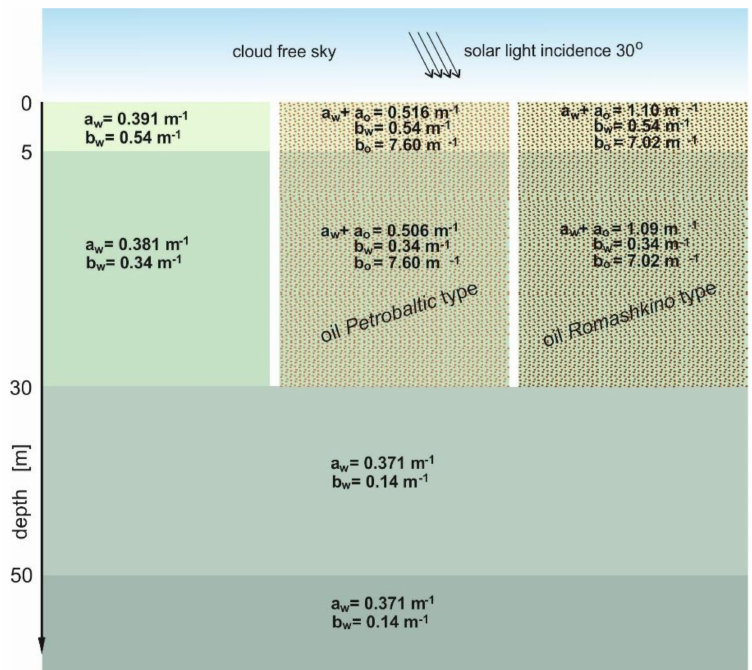
Figure 2. Optical model of the sea basin for a sample wavelength (655 nm) applied for Monte Carlo simulations of radiative